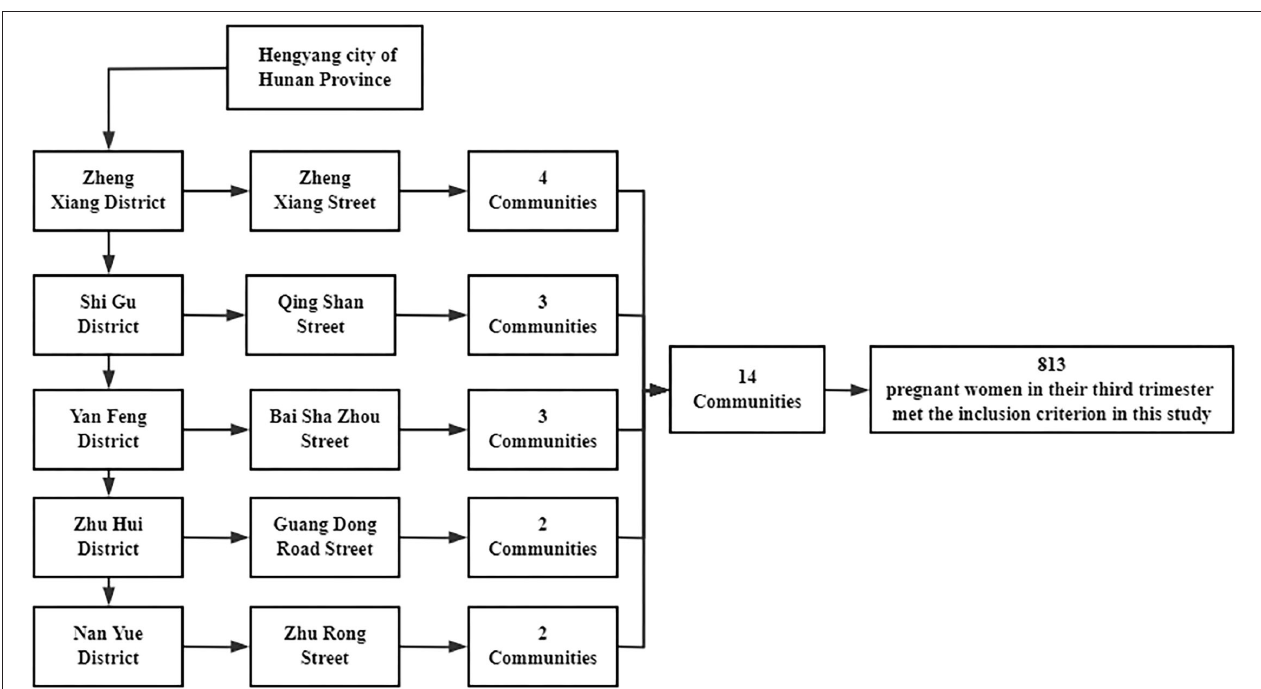
FIGURE 1 | Sampling strategy for the 14 communities of Hengyang